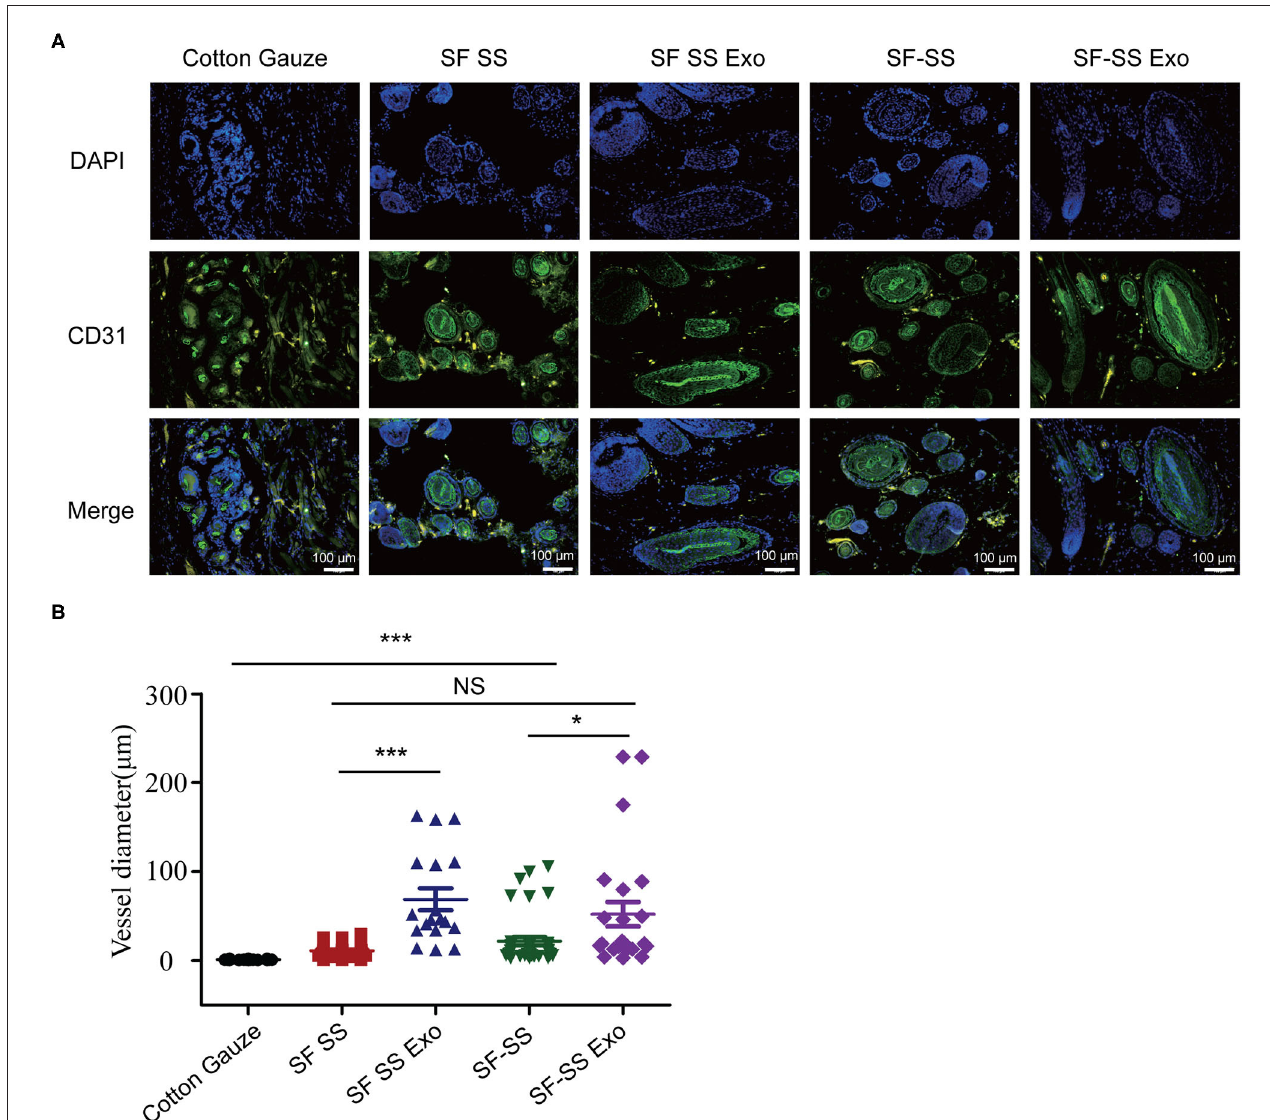
FIGURE 5 | The immunogenicity of SF SS and SF-SS hydrogel sponges. (A) Immunofluorescence staining of CD31 in skin wound treated by SF SS and SF-SS hydrogel and UMSC-Exo encapsulated in SF SS and SF-SS hydrogel. SF SS Exo, the Exo was delivered by SF SS composite hydrogel; SF-SS Exo, the Exo was delivered by SF-SS composite hydrogel. (B) Quantification of vessel diameter by Image J. Data is shown as mean ± standard deviation ( n = 3). ns, no significant difference, * p < 0.01, *** p <